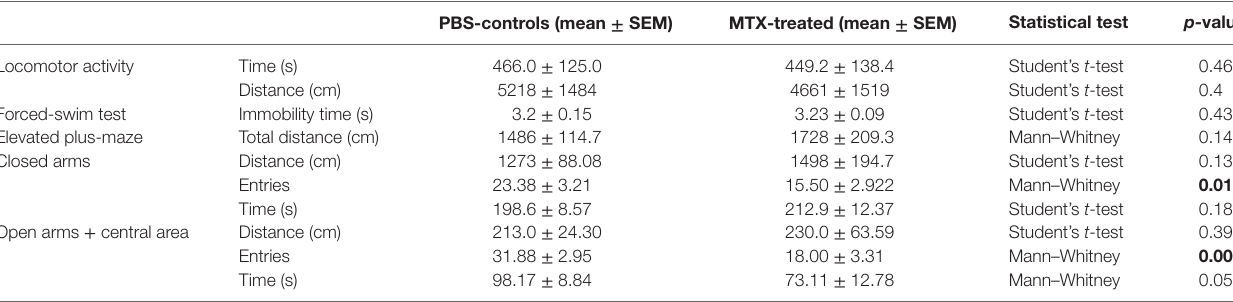
TaBle 1 | Behavioral tests results.